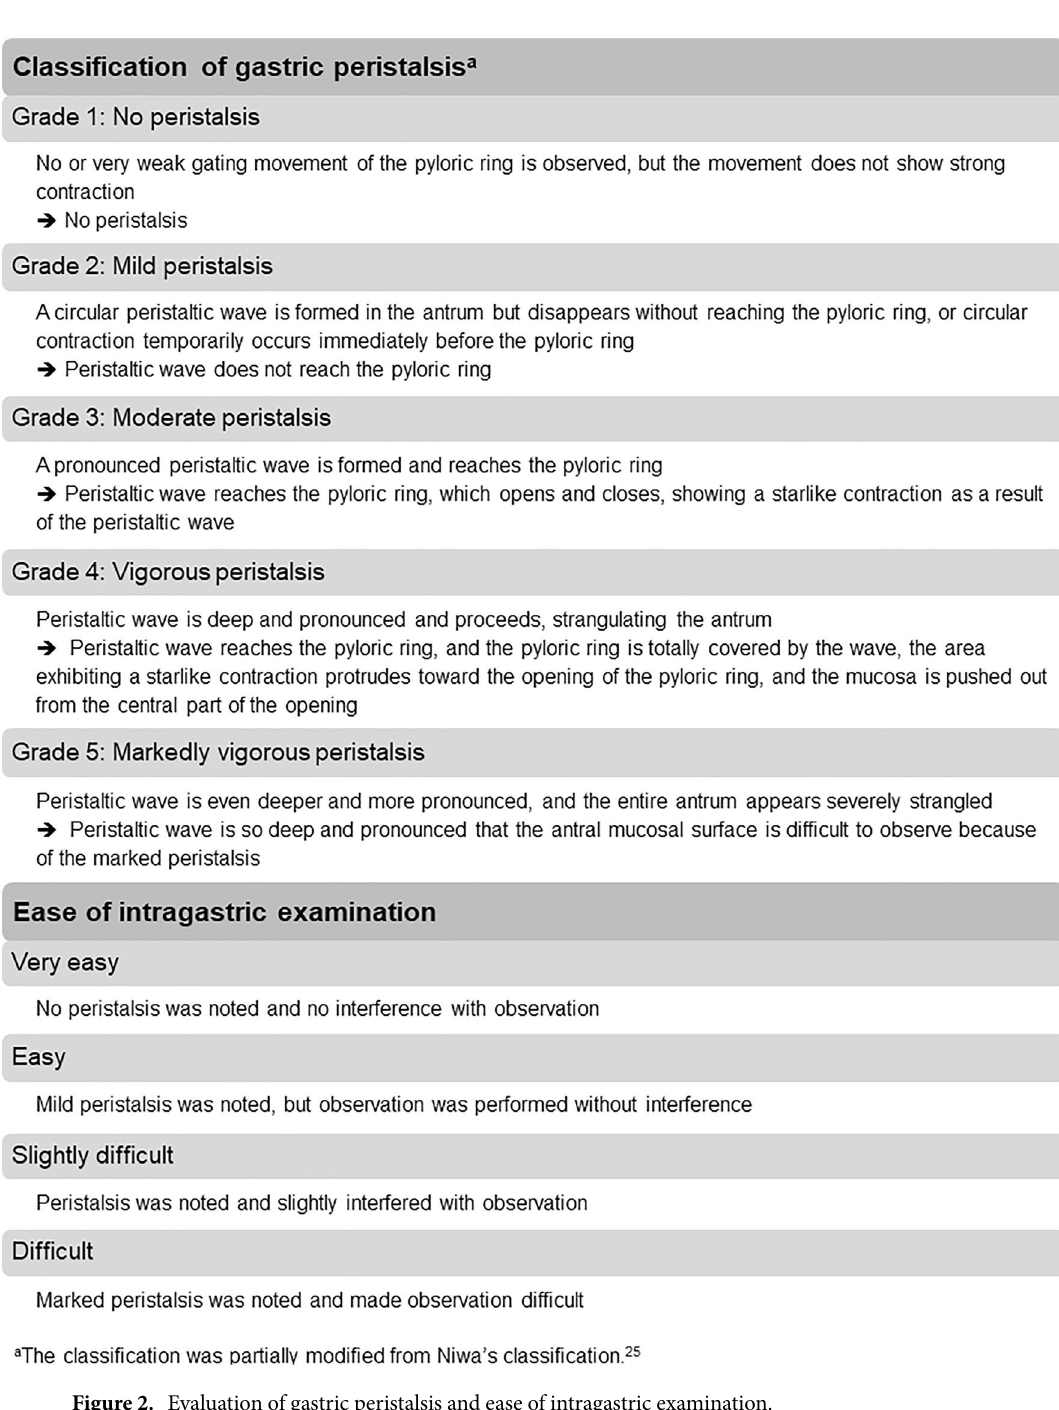
Figure 2. Evaluation of gastric peristalsis and ease of intragastric